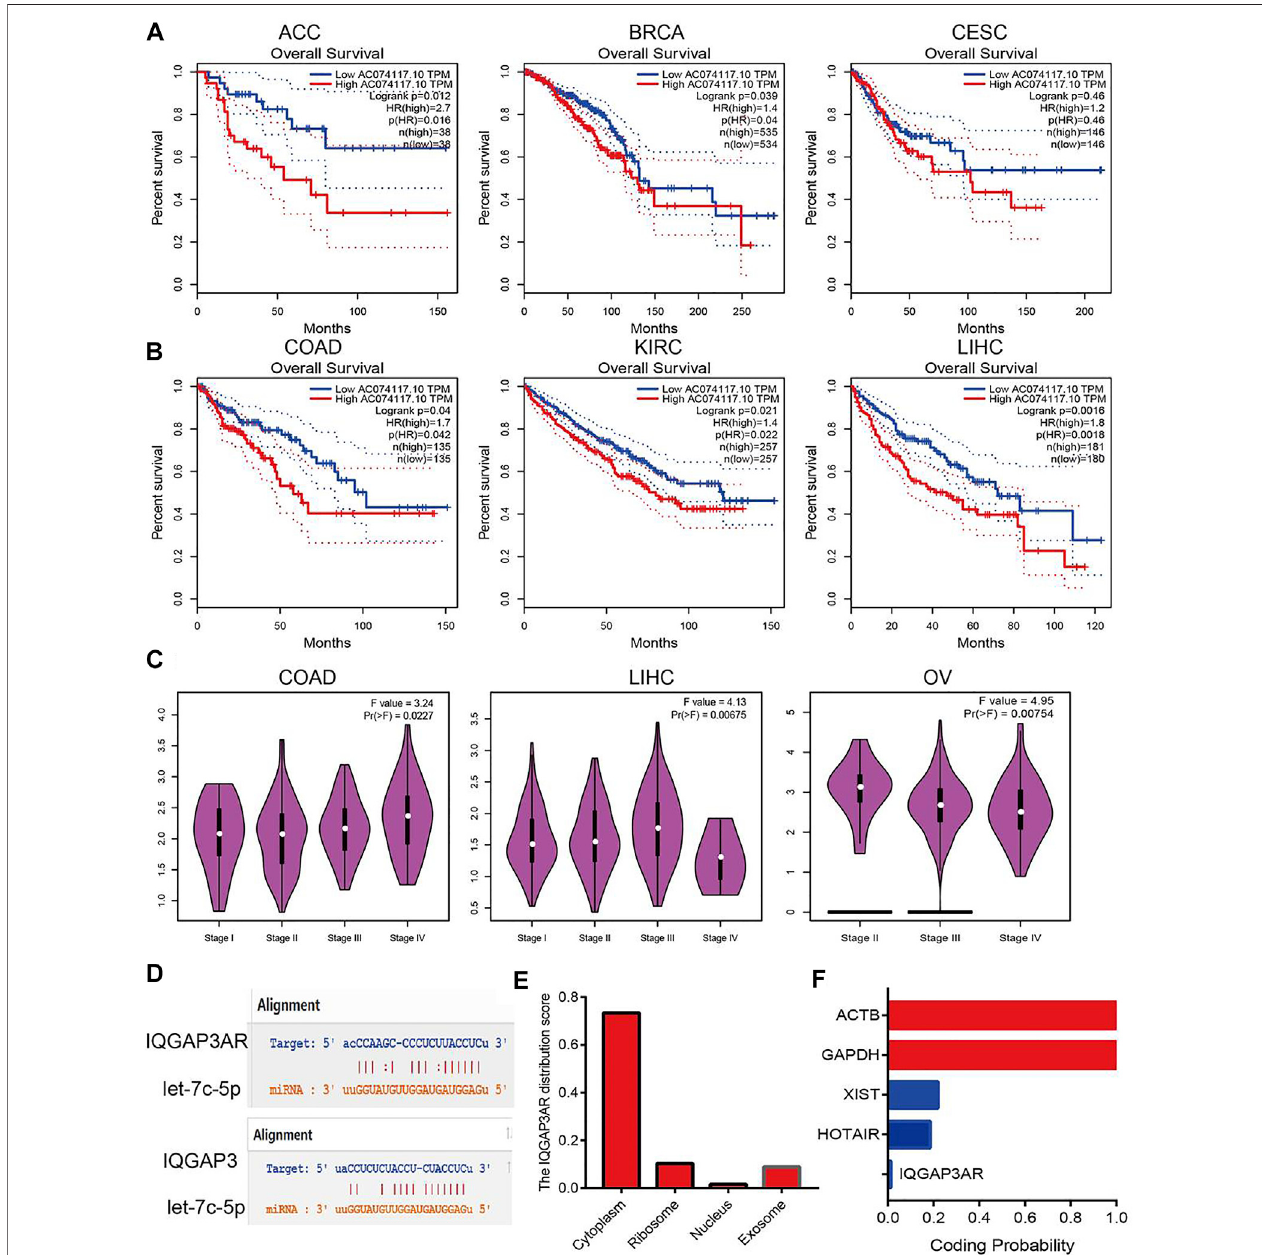
FIGURE 10 | Analysis upstream lncRNA of let-7c-5p in pan-cancer. (A) The prognosis of IQGAP3AR in ACC, BRCA, and CESC was analyzed by using starBase. (B) TheprognosisofIQGAP3ARin COAD, KIRC,and LIHC wasanalyzedbyusing starBase. (C) Thecorrelation betweentheIQGAP3ARand tumorstage in COAD, LIHC, and OV was analyzed by using starBase. (D) The target sites between the IQGAP3, let-7c-5p, and IQGAP3 were predicted by using starBase. (E) The subcellular localization of IQGAP3 was analyzed by using the lncLocator tools. (F) The coding potential of IQGAP3 was analyzed by using the coding potential